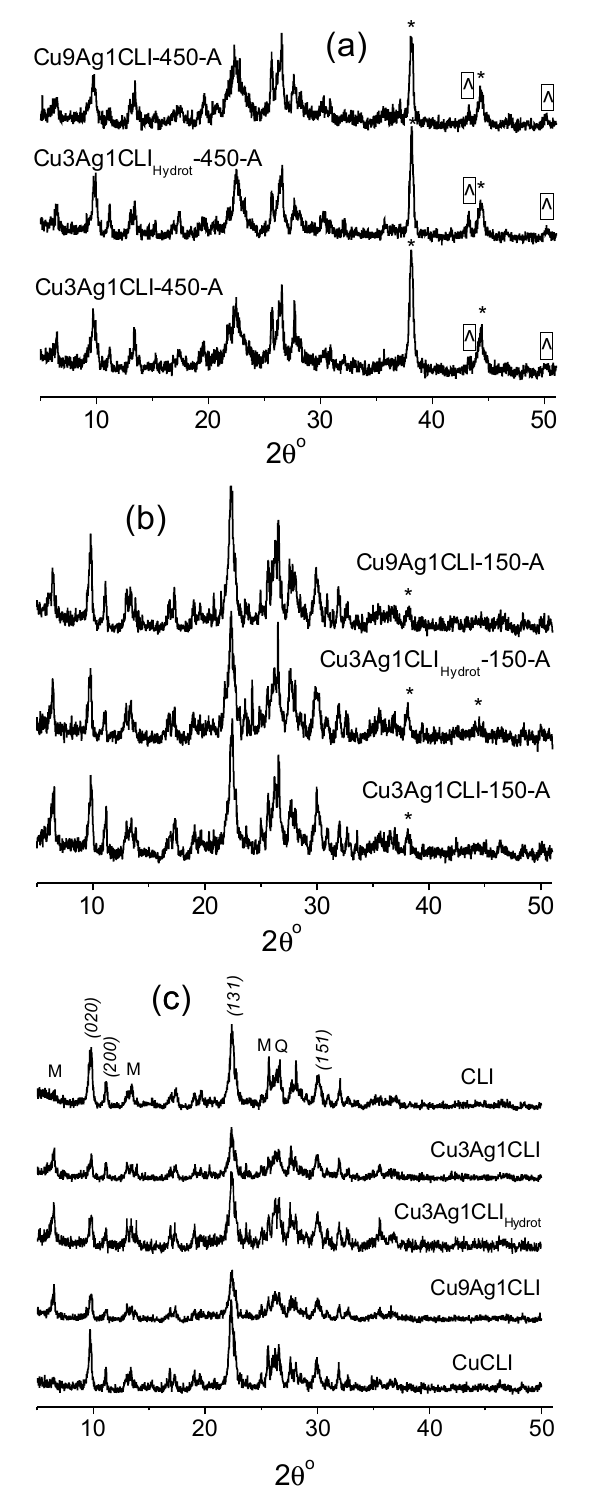
Figure 3. XRD patterns of the aged bimetallic samples reduced at 150 °C ( b ) and 450 °C ( a ). The peaks belonging to metallic silver and copper are marked with “*” and “^” symbols respectively. Patterns of the starting natural clinoptilolite and exchanged but not yet reduced samples are included ( c ). The Miller indexes ( hkl ) of the main diffraction peaks for clinoptilolite are shown. The main diffraction peaks of mordenite (M) and quartz (Q) are shown also.